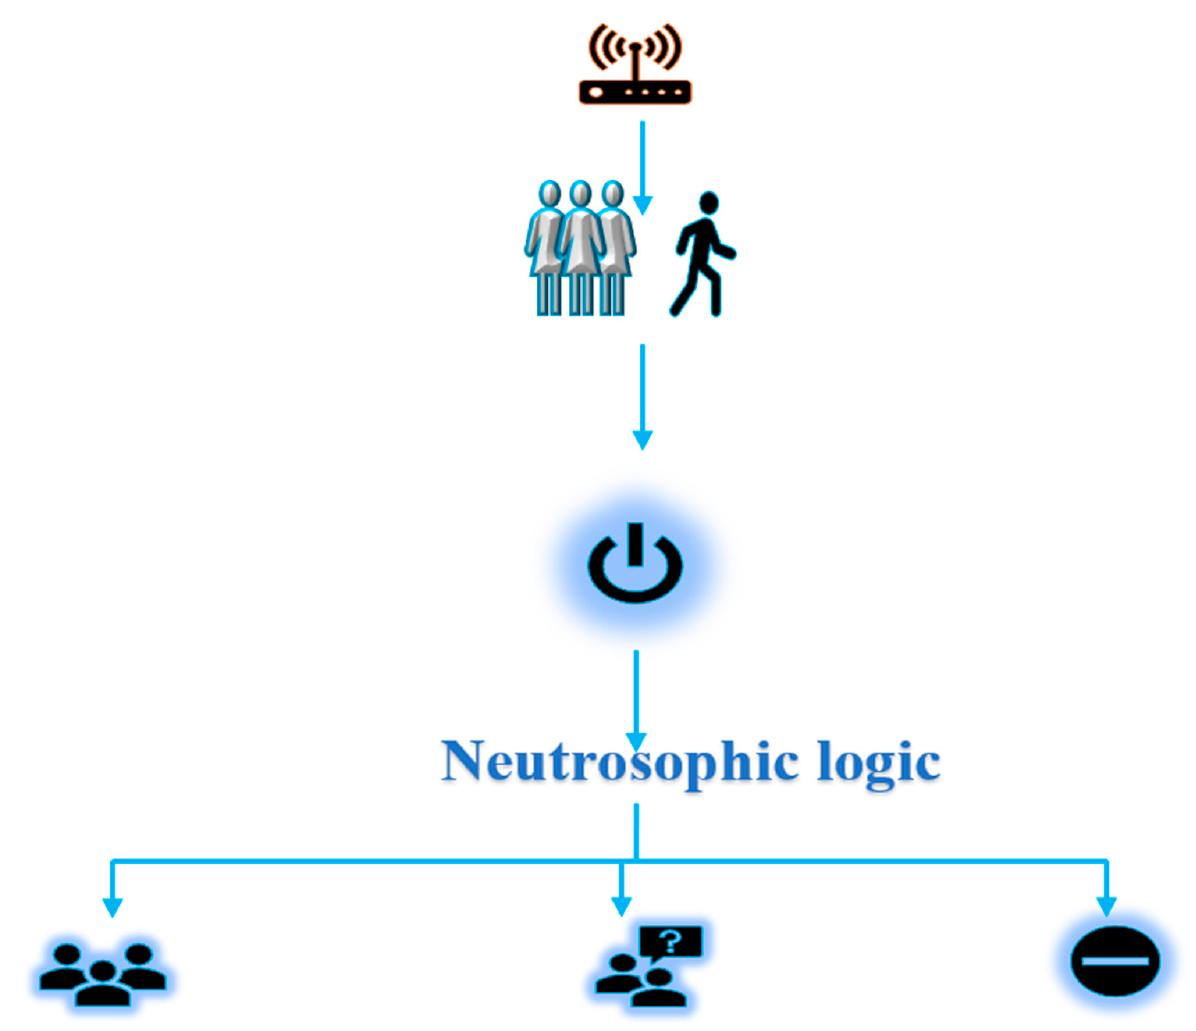
Figure 2. Pictorial representation of sensor work.